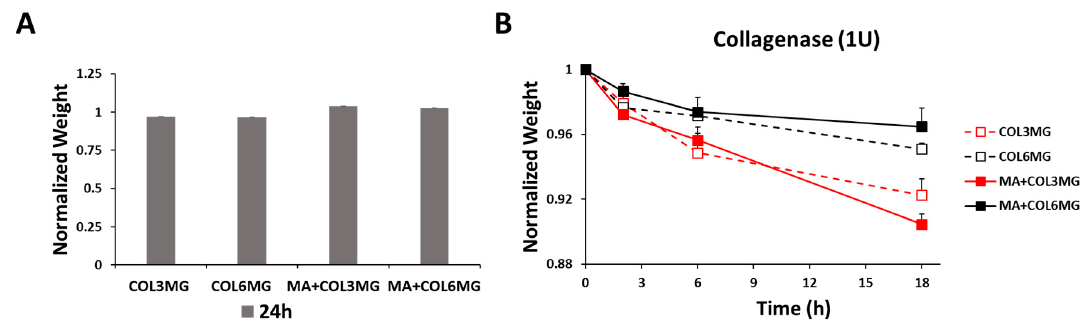
Figure 3. Swelling ( A ) and degradation ( B ) of the hydrogels. Collagenase type I used for the degradation test. Note that the error bars were estimated by the standard deviation of three samples.